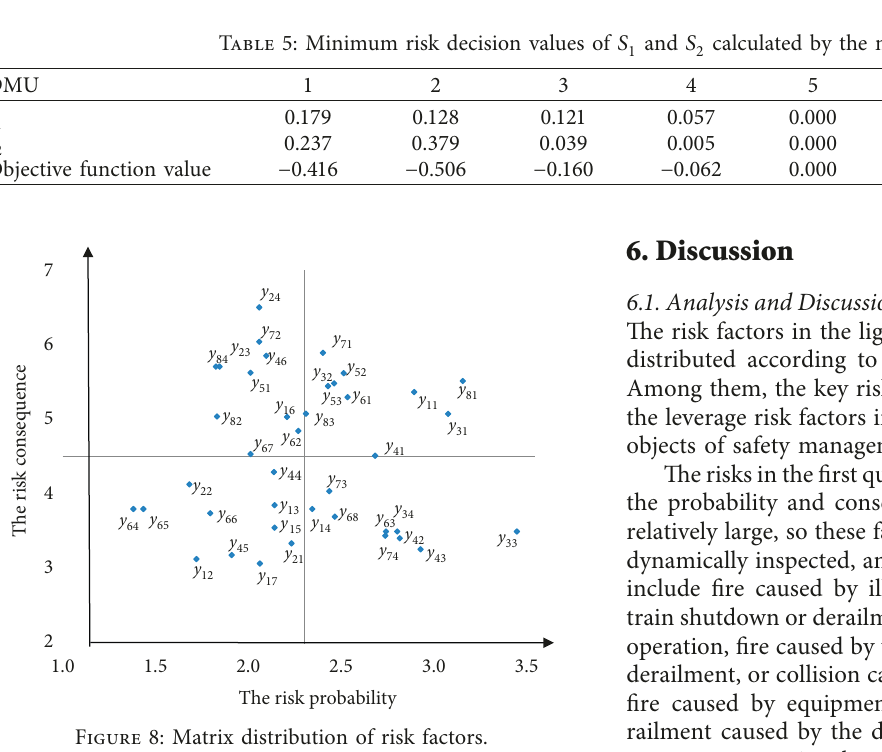
Table 5: Minimum risk decision values of S